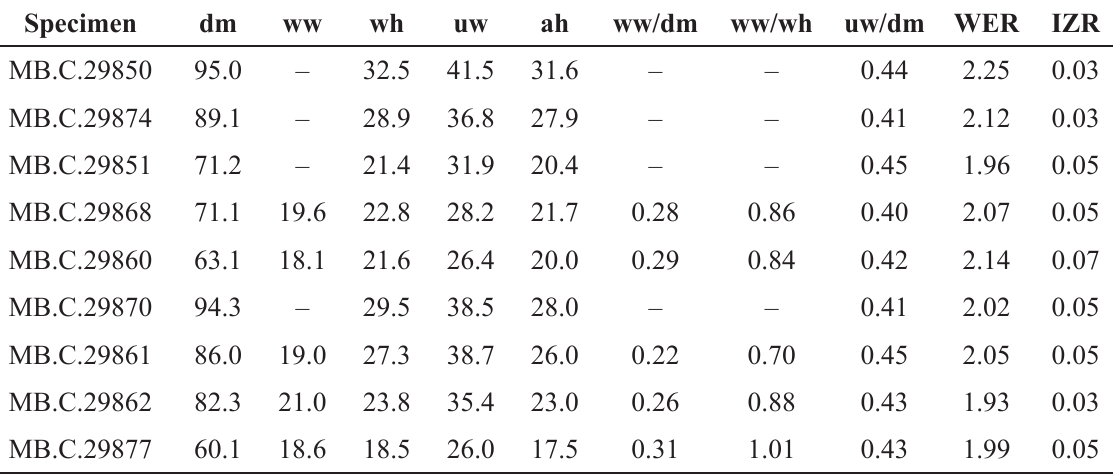
Table 16. Conch dimensions (partly estimated) and ratios of selected specimens of Paratirolites baghukensis Korn & Hairapetian sp. nov. from Baghuk